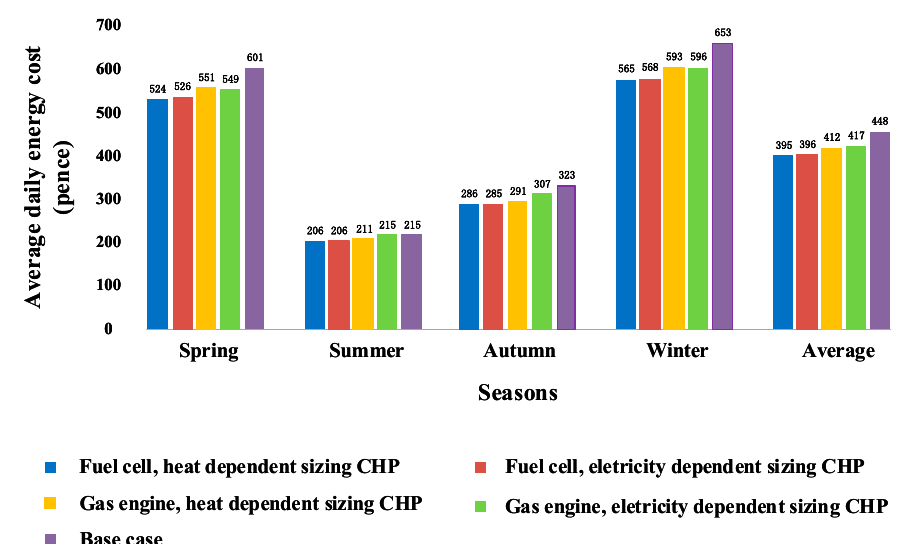
Figure 10. Different daily operational costs based on different optimising criteria.